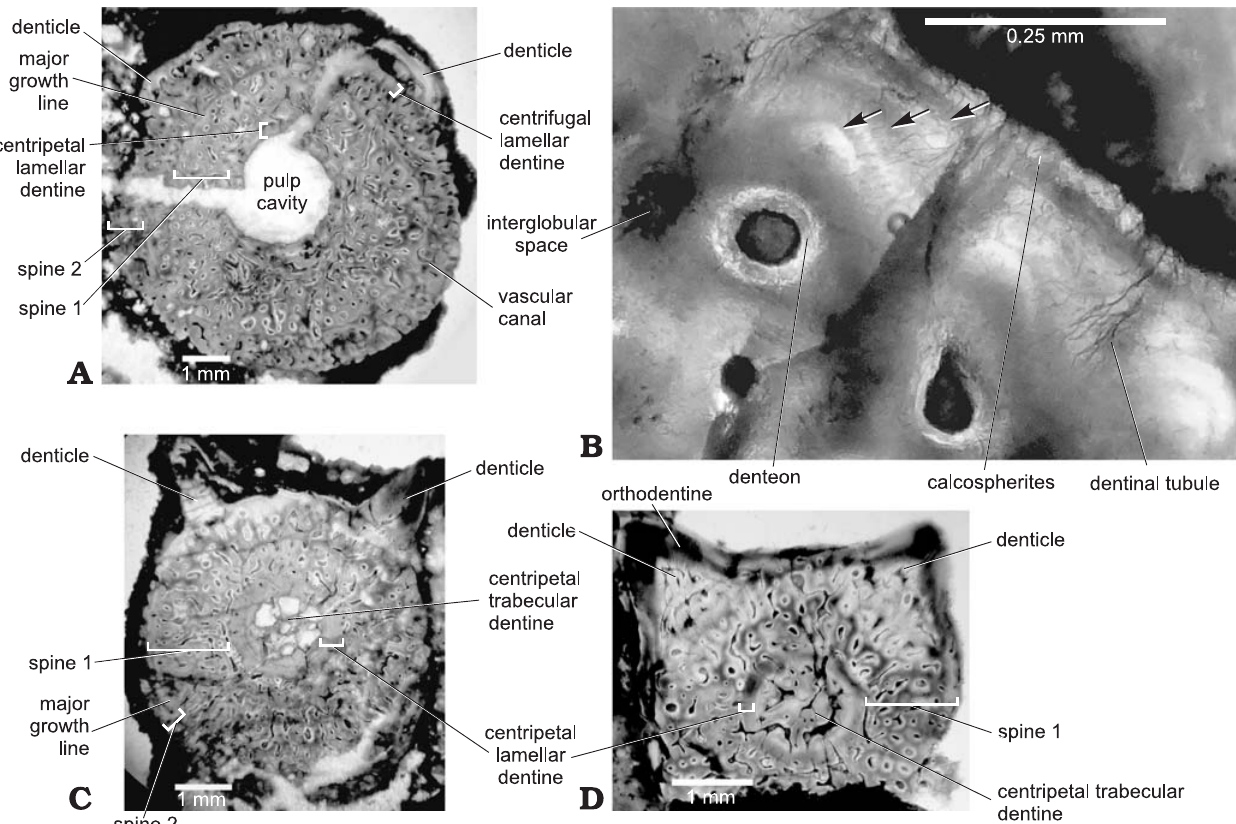
Fig. 5. Serial cross-sections ( A , C , D ) of dorsal spine of Orthacanthus platypternus (Cope, 1884), Lower Permian, Craddock Bone Bed, Texas, USA; specimen HMNS-J3, where A represents the most proximal section and D is the most distal. B . Detail of section in A showing three minor growth lines close to the base of the right denticle in the figure